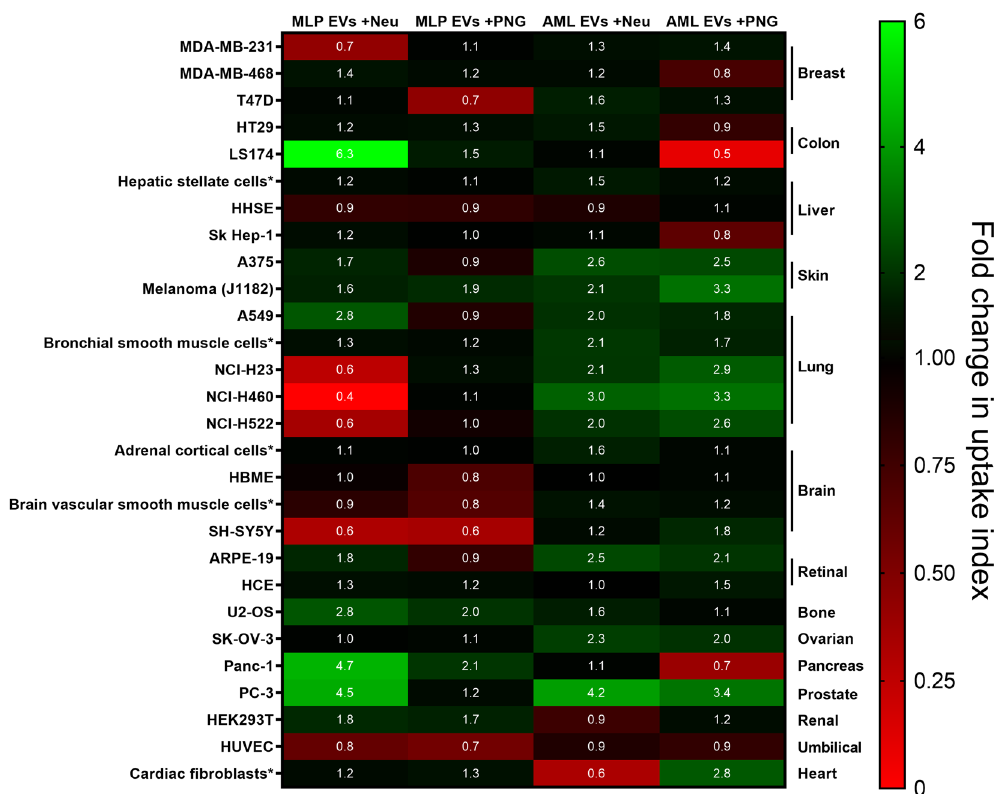
Figure 8. High-content uptake analysis of EVs with modified glycosylation pattern. A panel of 28 human cell lines were incubated with native EVs or with glycosidase-treated EVs during 16 hours. Confocal images